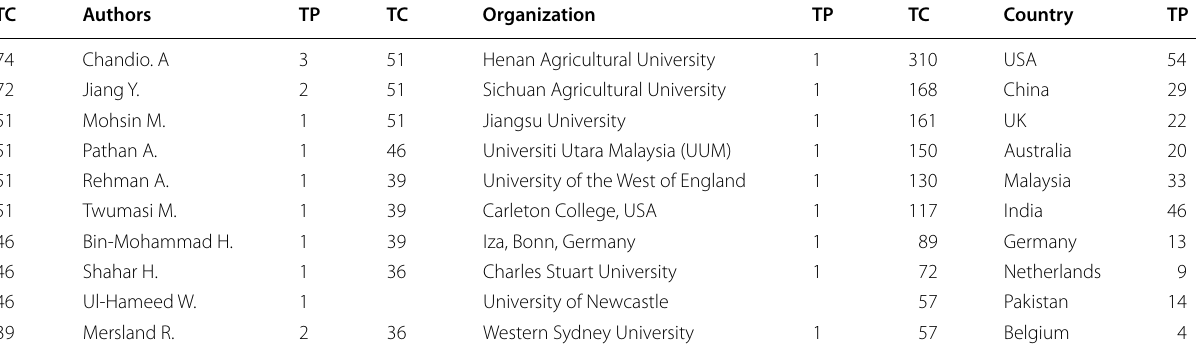
Table 3 Top 10 authors, institutions, and countries